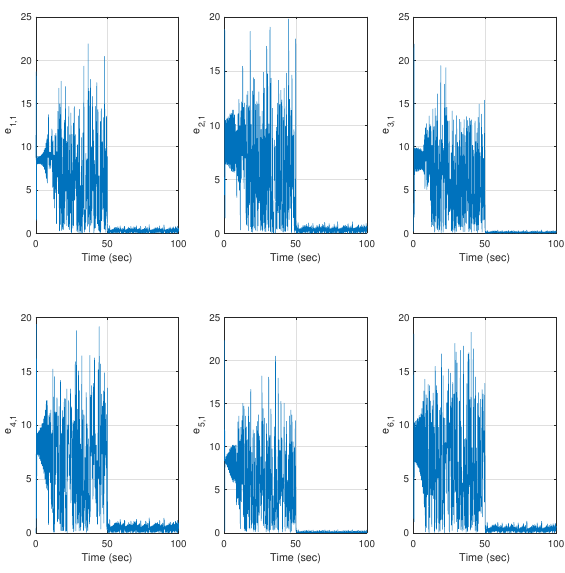
Figure 4. Time evolution of the norm of the synchronization errors between the mean value and the state x i ,1 .